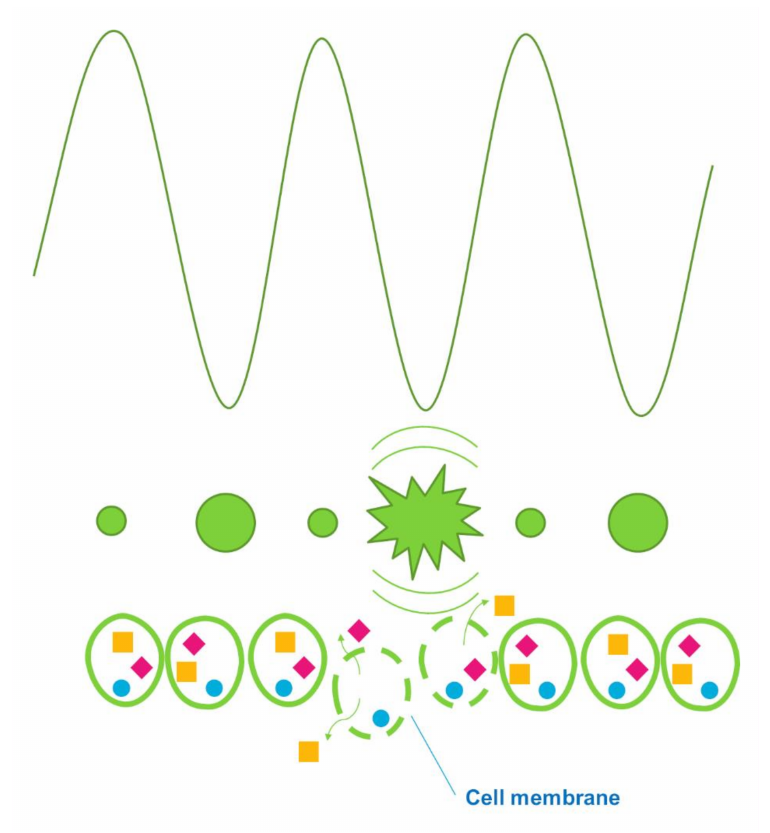
Figure 3. A scheme of ultrasound impact on the plant